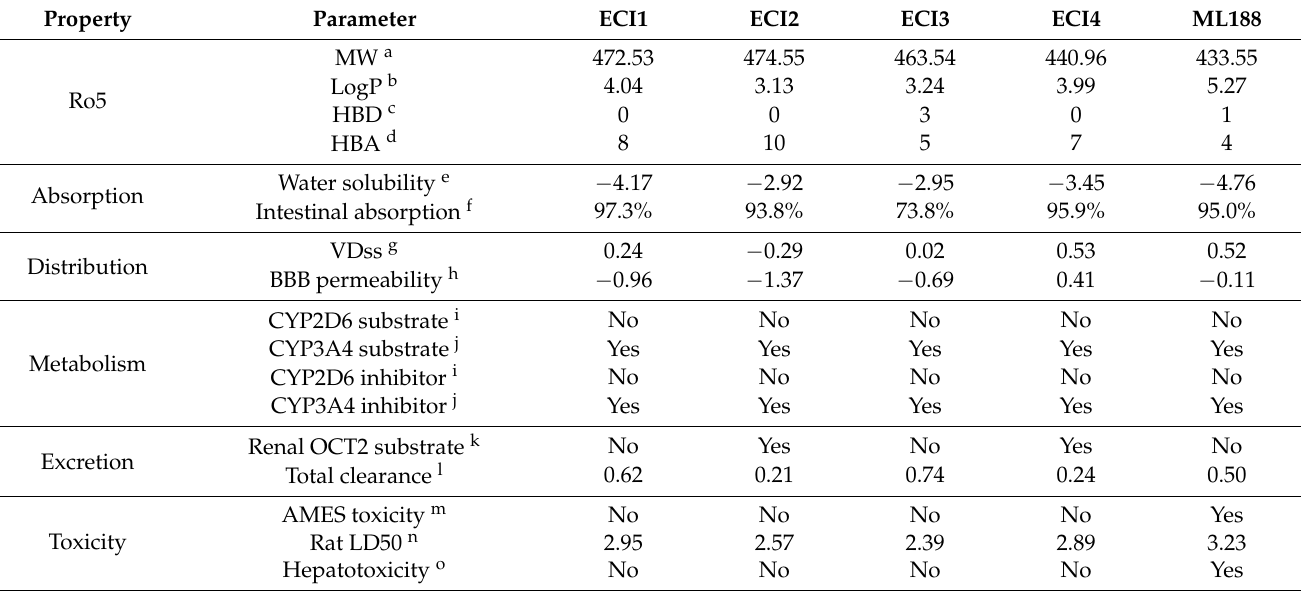
Table 1. Predicted parameters of Lipinski’s rule of five (Ro5) and ADMET for the four effective candidate inhibitors (ECI1-4) and